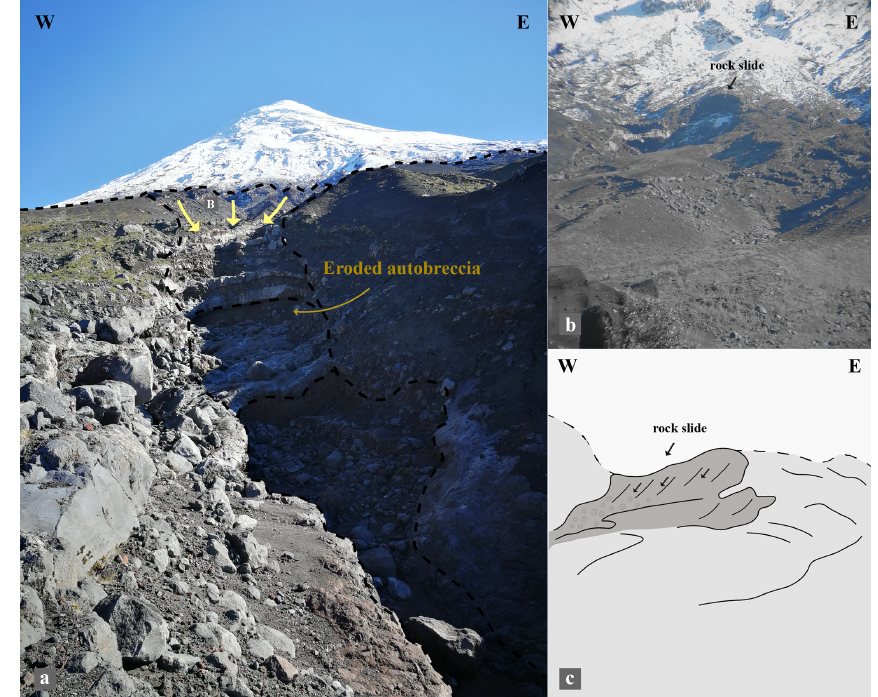
Figure 3. A 15m high scarp showing the stratigraphy of the volcano at this point, composed of alternating volcanic and lava deposits.